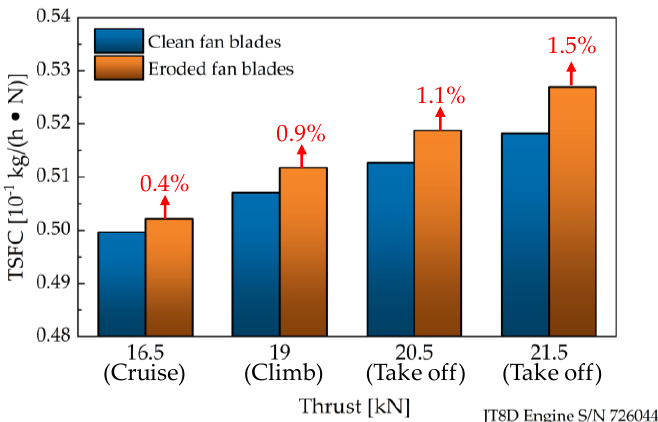
Figure 1. Thrust specific fuel consumption (TSFC) comparison of eroded versus clean fan blades. Reproduced from